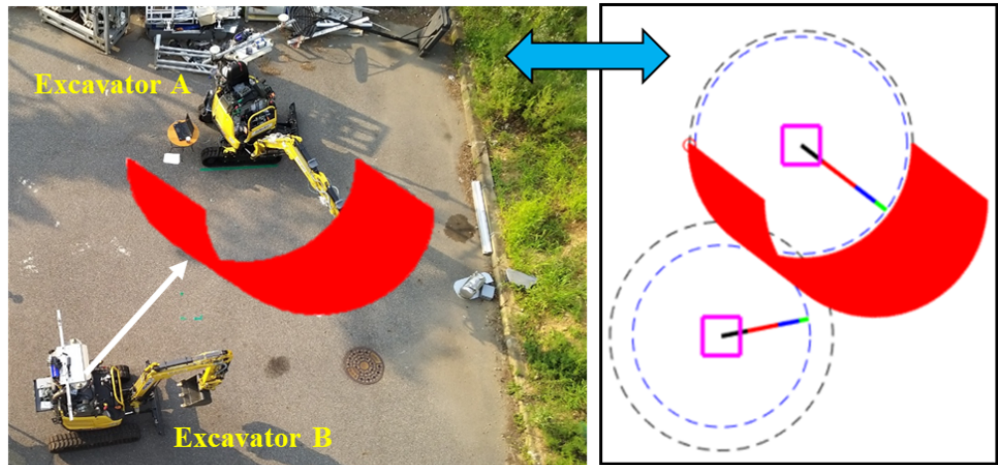
Figure 17. The experimental results about obstacle generation for driving guidance; The left is made intentionally by manual for clear understanding.